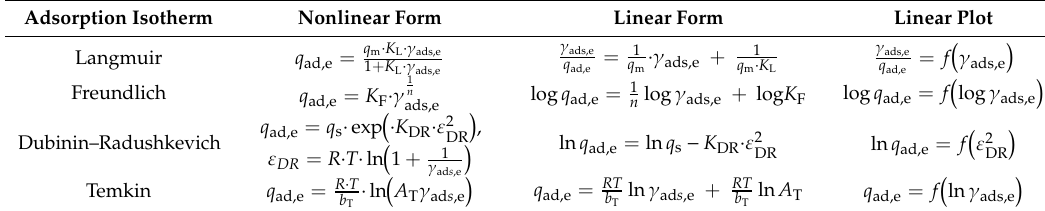
Table 3. Adsorption isotherm